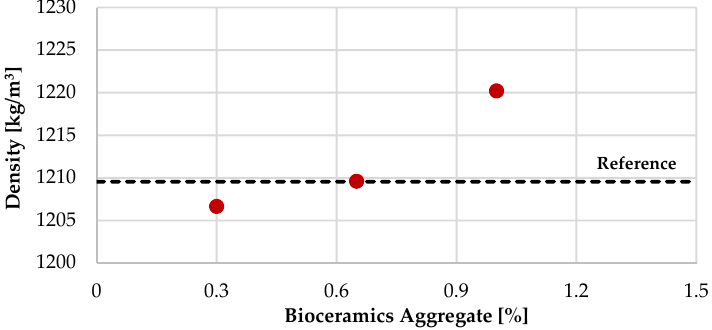
7 of 16 Table 6. Summary table with all the test results obtained for gypsum plasters. Samples